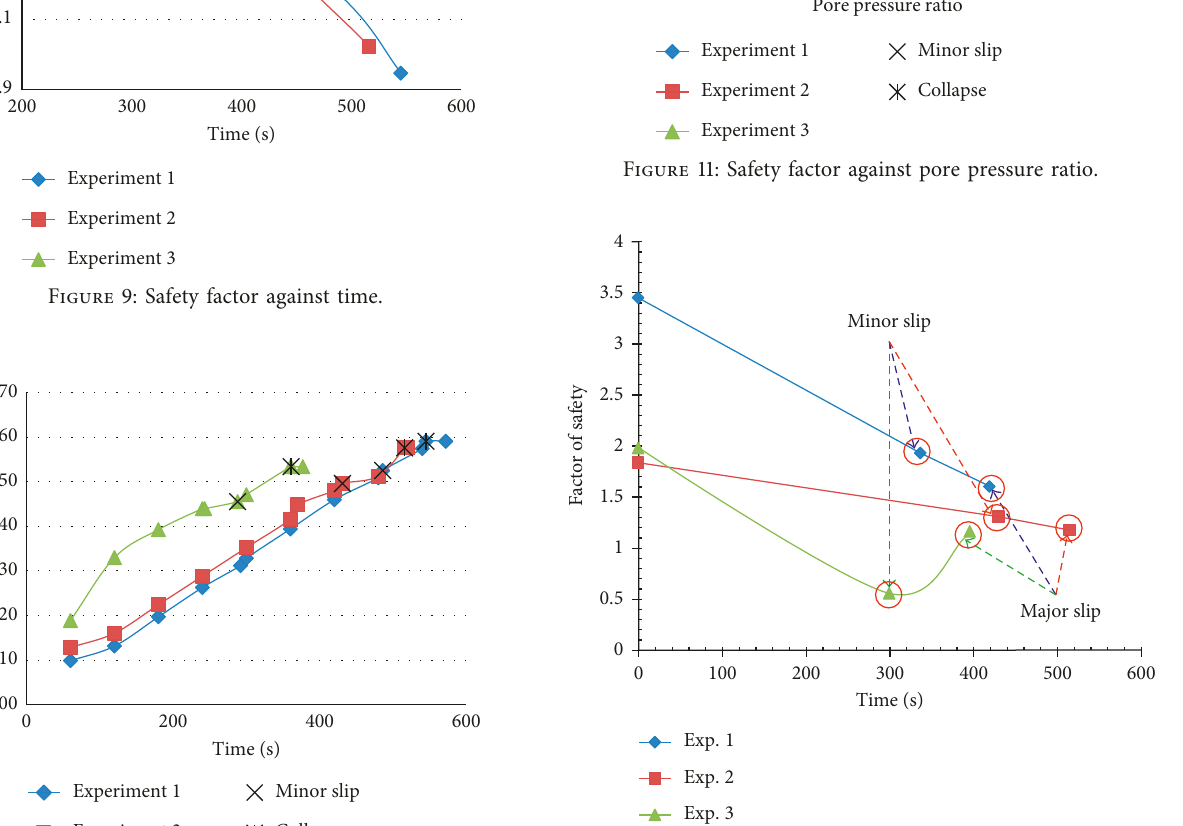
Figure 12: Factor of safety against